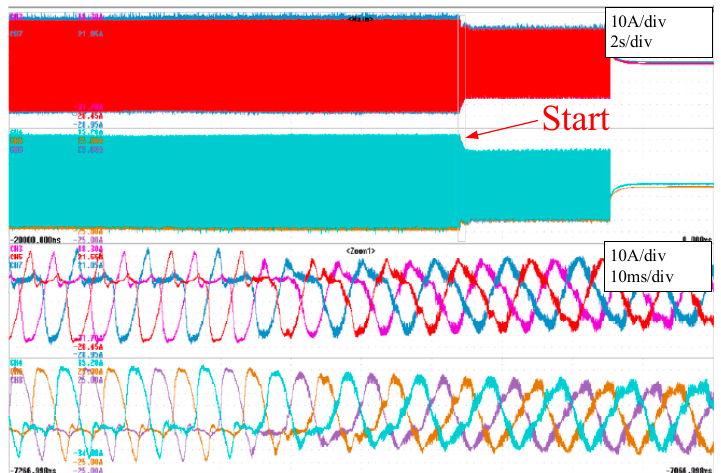
Figure 27. Arm currents with repetitive controller. Table 3. Grid Current Total Harmonic Distortion.